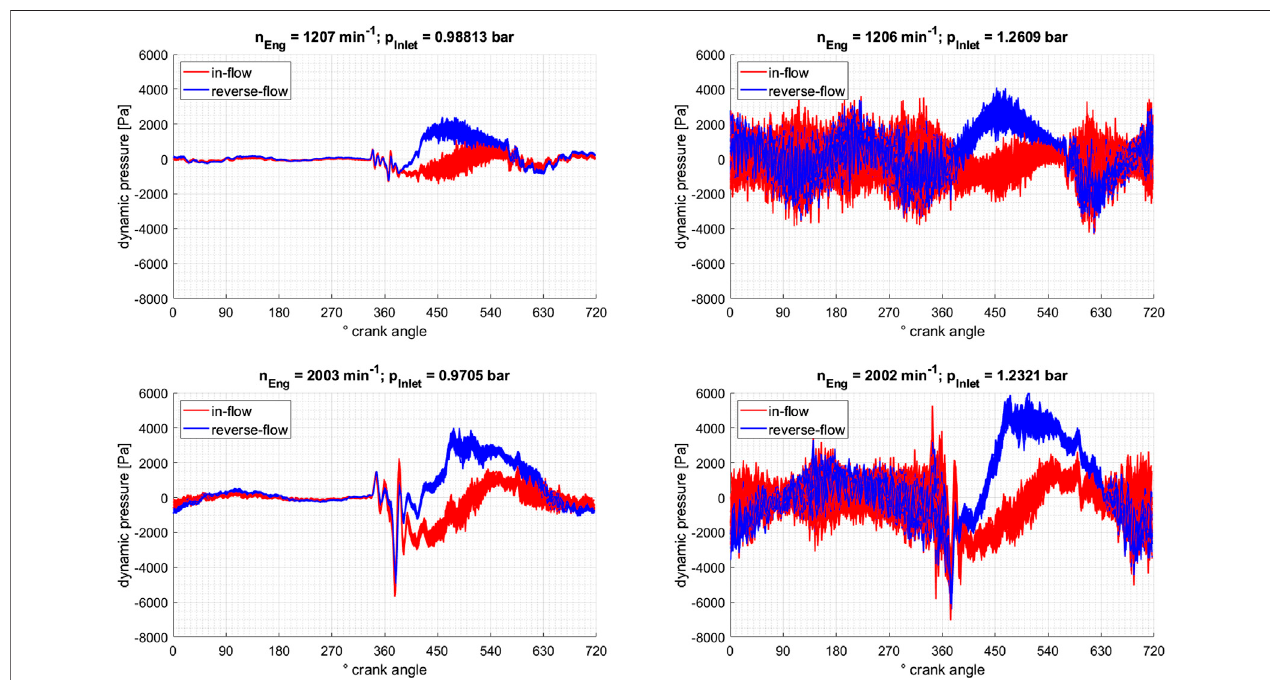
FIGURE 4 | Individual cycle dynamic pressure in the inlet duct of 50 consecutive cycles for four measuring